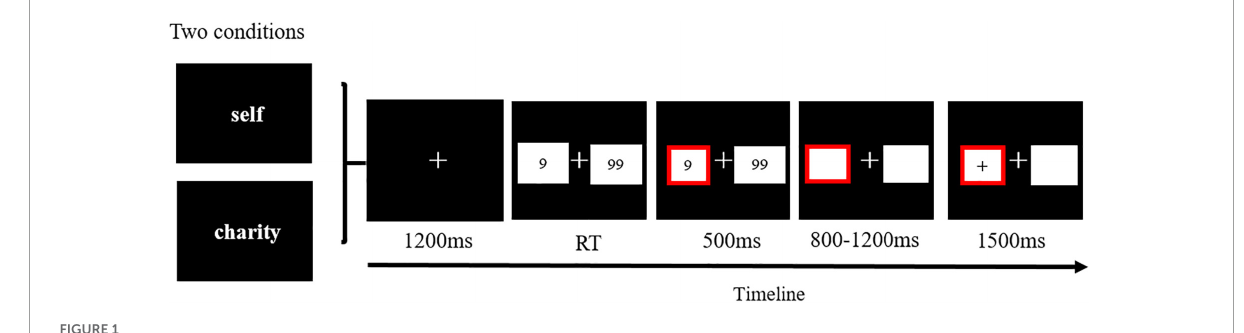
FIGURE1 An illustration of a single